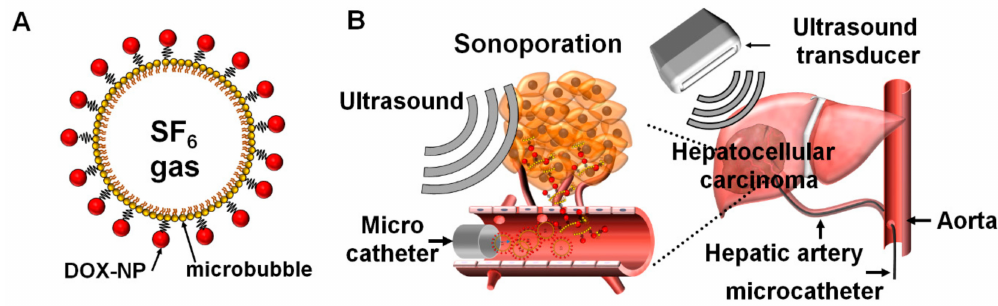
Figure 1. Schematic illustrations of ( A ) the ADMB complex and ( B ) treatment procedure for the intra-arterial administration of the ADMB complex using microcatheters under ultrasound